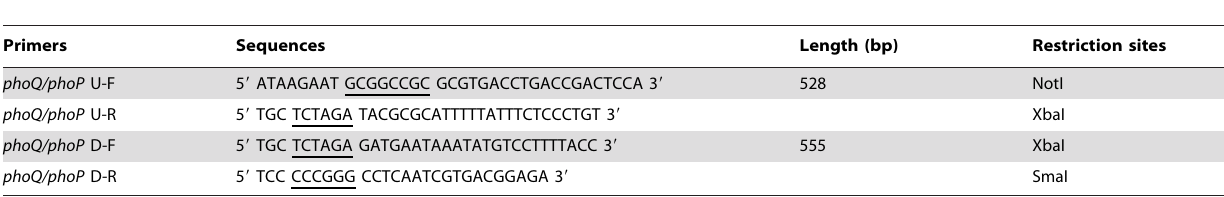
Table 3. Primers used in homologous recombinations to construct knockout